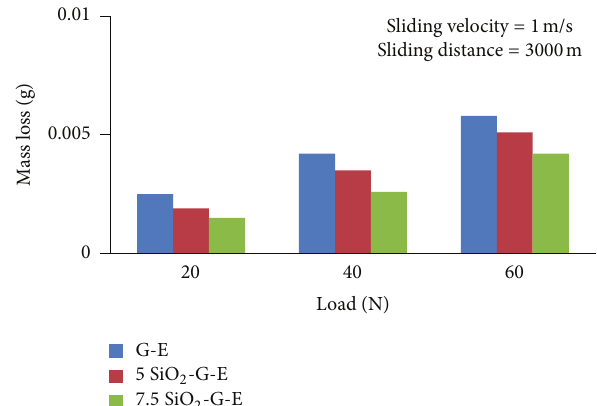
Figure 15: Mass loss of SiO 2 filled G-E composites.